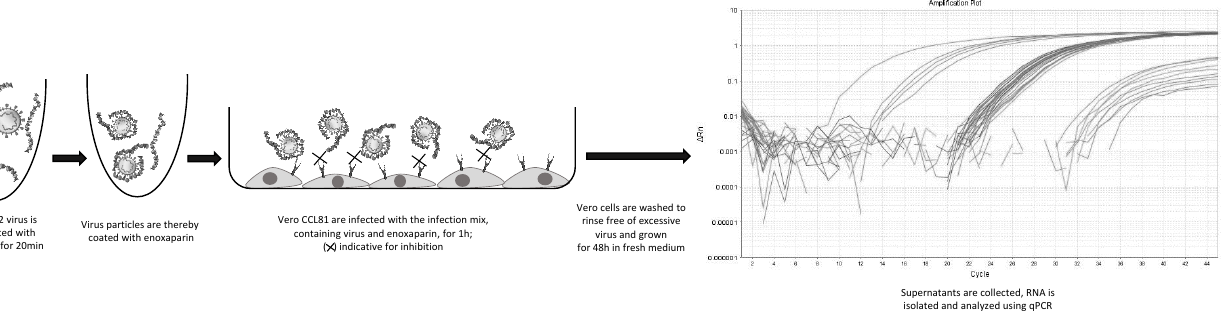
Figure 2. Flow chart of experimental set-up for viral inactivation